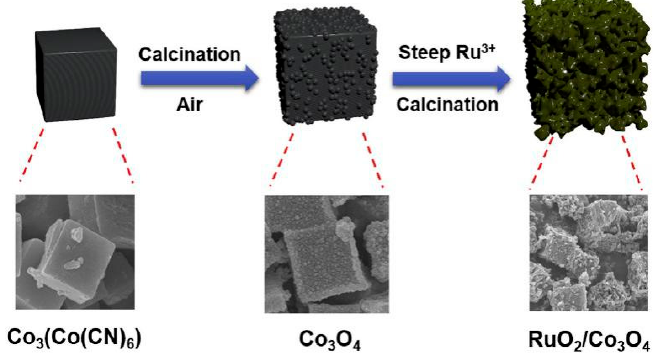
Figure 9. Schematic illustration of RuO 2 /Co 3 O 4 . Copied with permission from [91]. Copyright © 2020, Elsevier.